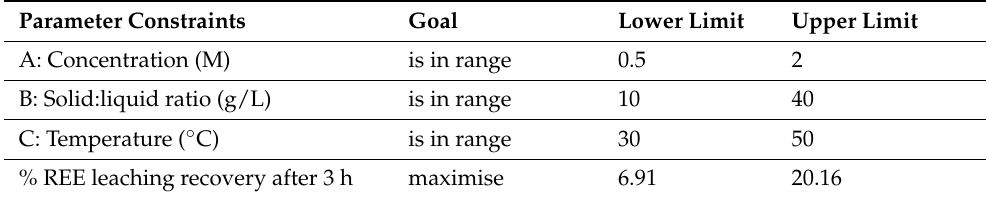
Table 7. Leaching parameter settings for the optimised response of RC1 and DC1.